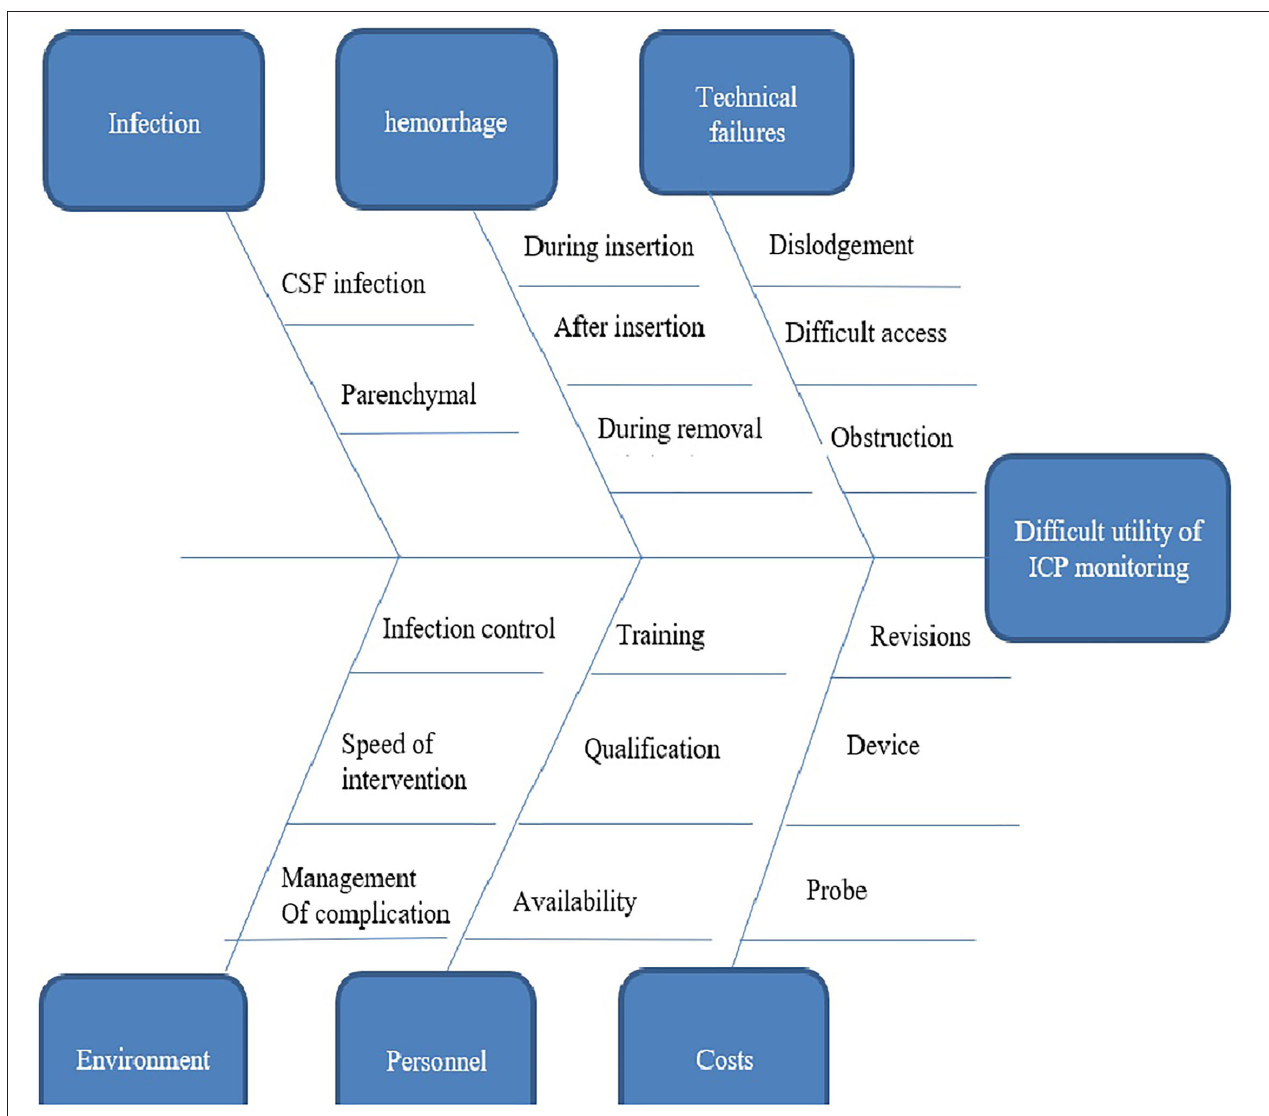
FIGURE 2 | Fish bones diagram showing reasons behind the reluctance to use intracranial pressure monitoring based management of severe traumatic brain injury in our